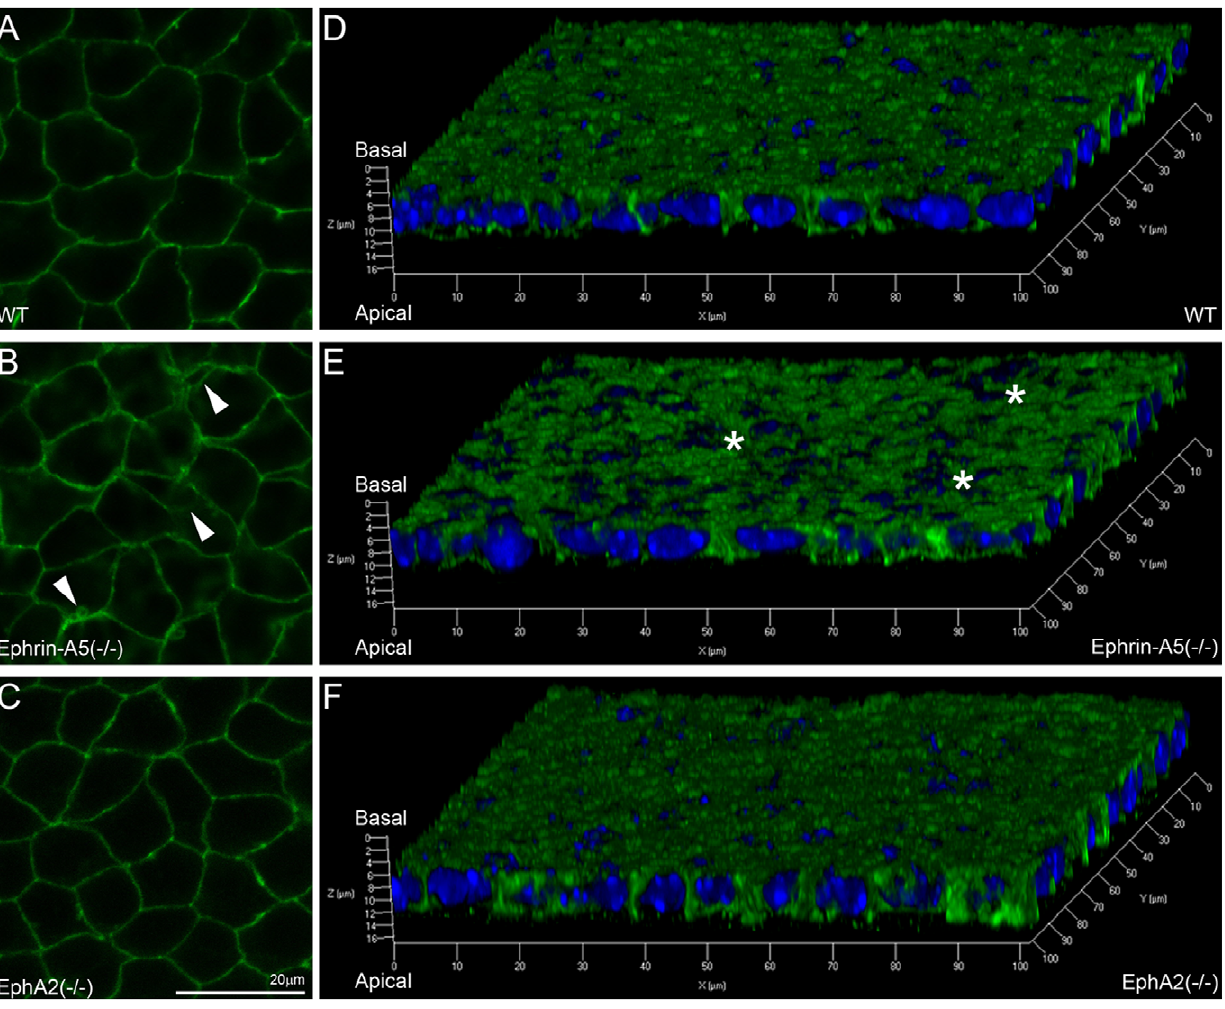
Figure 4. E-cadherin distribution in WT, ephrin-A5(-/-) and EphA2(-/-) lens capsule flat mounts. Fluorescent images reveal normal staining signals of E-cadherin in WT and EphA2(-/-) anterior epithelial cells (A and C) but alterations in the ephrin-A5(-/-) anterior epithelium (B, indicated by arrowheads). Three-dimensional reconstructions of z-stack images labeled for E-cadherin (green) and DAPI (blue, nuclei) of lens epithelial cells from P21 WT, ephrin-A5(-/-) and EphA2(-/-) lens capsule flat mounts (D, E and F). There is a notable disruption of E-cadherin staining in ephrin- A5(-/-) anterior epithelial cells as compared to those in WT and EphA2(-/-) cells. Scale bar, 20 m m.